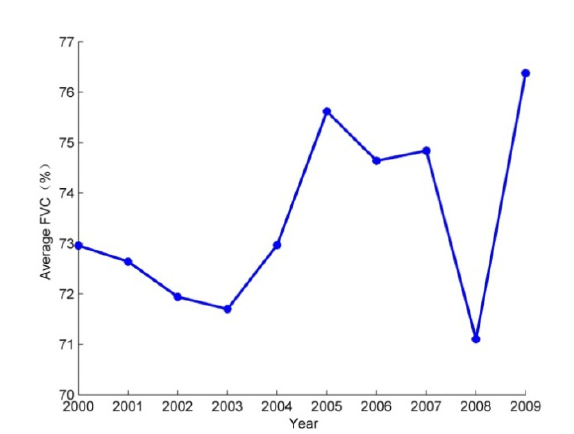
Figure 2. Changes of average FVC in the source region of the Yellow River from 2000 to 2009